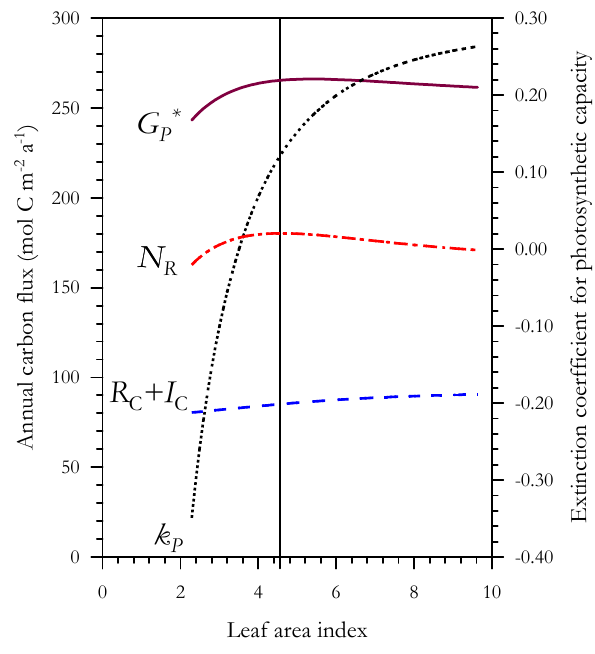
Fig. 3. Variations in the rate of Gross Primary production (in the absence of any leaf respiration in the light), G ∗ , the sum of leaf P respiration (day and night) plus investment costs in leaf construction ( R C + I C ) and the difference between the two, the annual net carbon gain of the canopy, N R as defined through Eq. (2) as a function of leaf area index, L . Associated variations in the extinction coefficient for photosynthetic capacity, k P , are also shown, with the vertical line indicating the L associated with the maximisation of N R